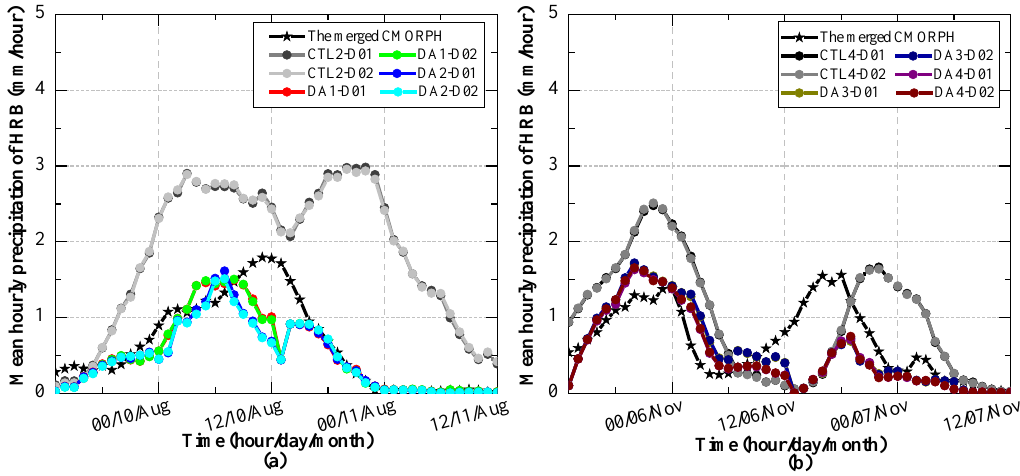
Figure 8. Mean hourly precipitation (mm/hour) of the basin via the merged CMORPH estimates and the CTL2, CTL4, and DA experiments for rainfall events in August ( a ) and November ( b ).